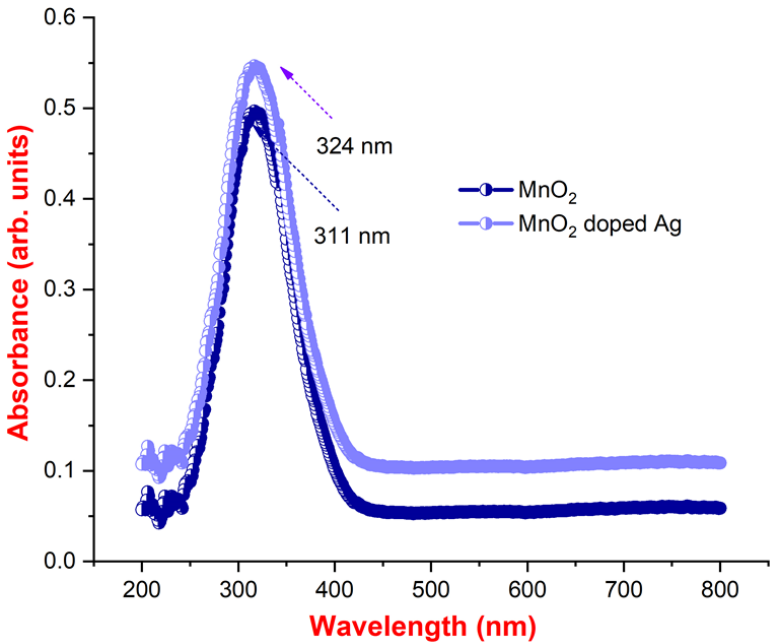
Figure 2. UV-visible spectrum of synthesised pure MnO 2 and MnO 2 doped with Ag nanoparticles.